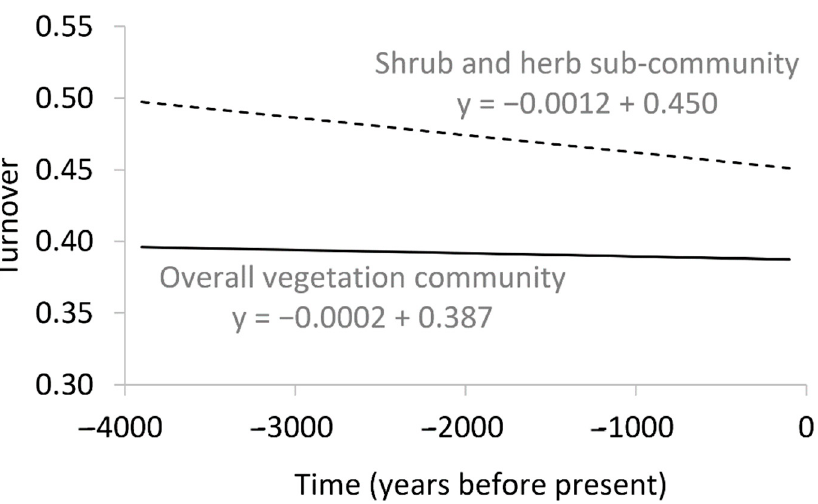
Table 2. Generalised Linear Models of within-site turnover in relation to time and mediating effects of latitude and altitude. Chi square values are likelihood ratio for overall models and Wald for fac- tors and interactions. Overall Vegetation Community Shrub and Herb Sub-Community